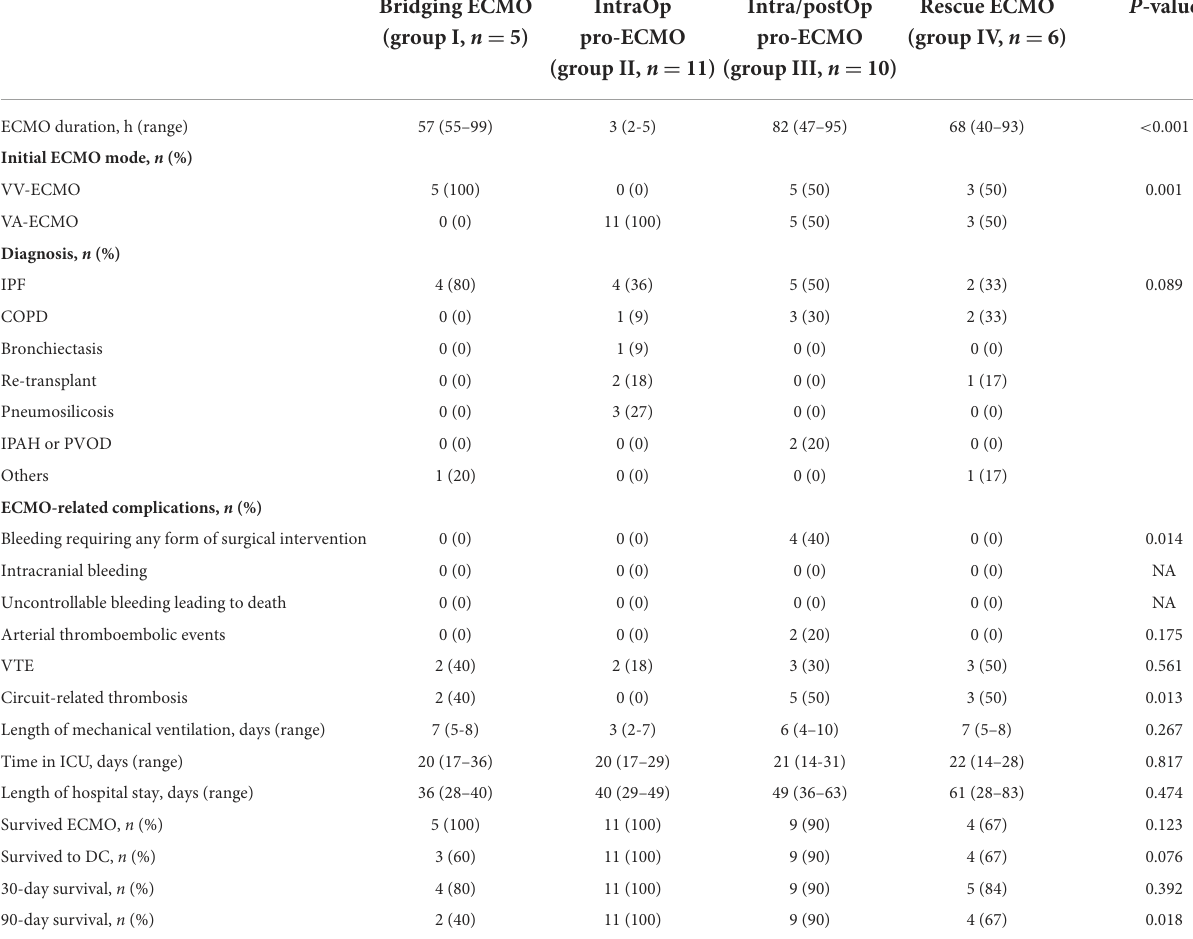
TABLE 4 Patient characteristics with different modes of ECMO